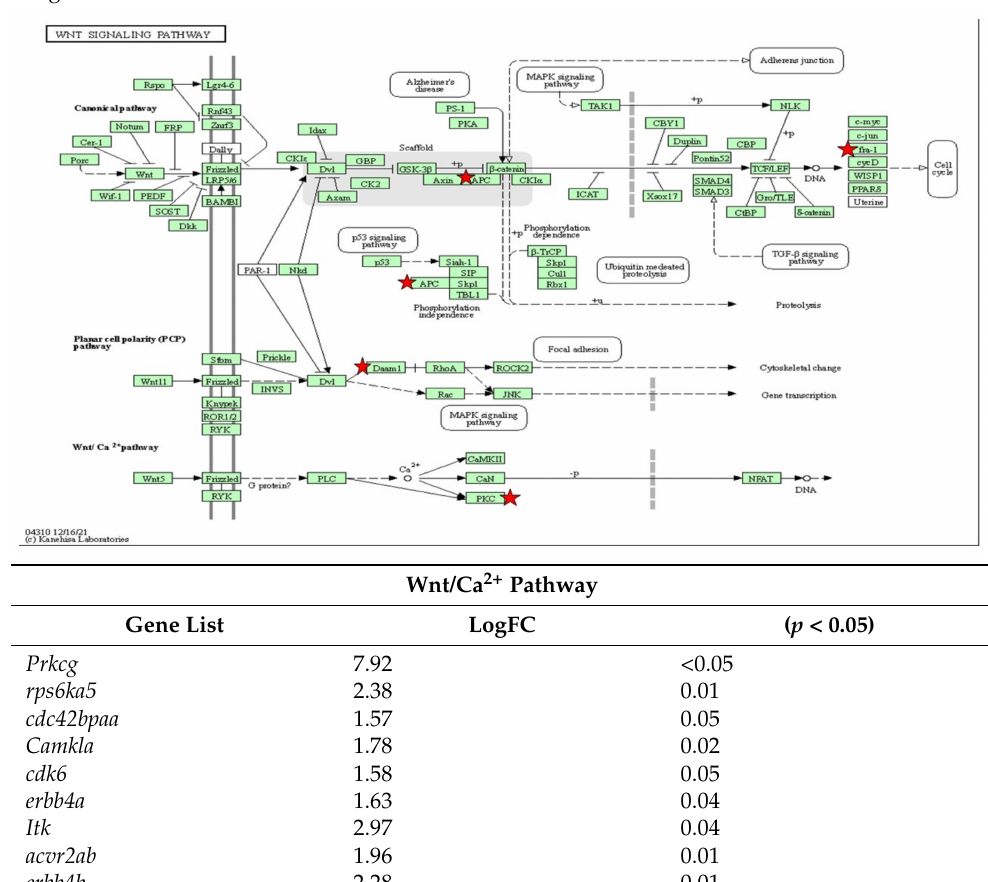
Table 6. The gene set enriched in the Wnt/Ca 2+ -signaling pathway in the DAVID platform. Wnt/Ca 2+ -signaling pathway depicted based on KEGG pathway with the significant differential expression gene enriched ( p < 0.05). The star (*) indicates the gene involved in the Wnt/Ca 2+ pathway integrated with Table